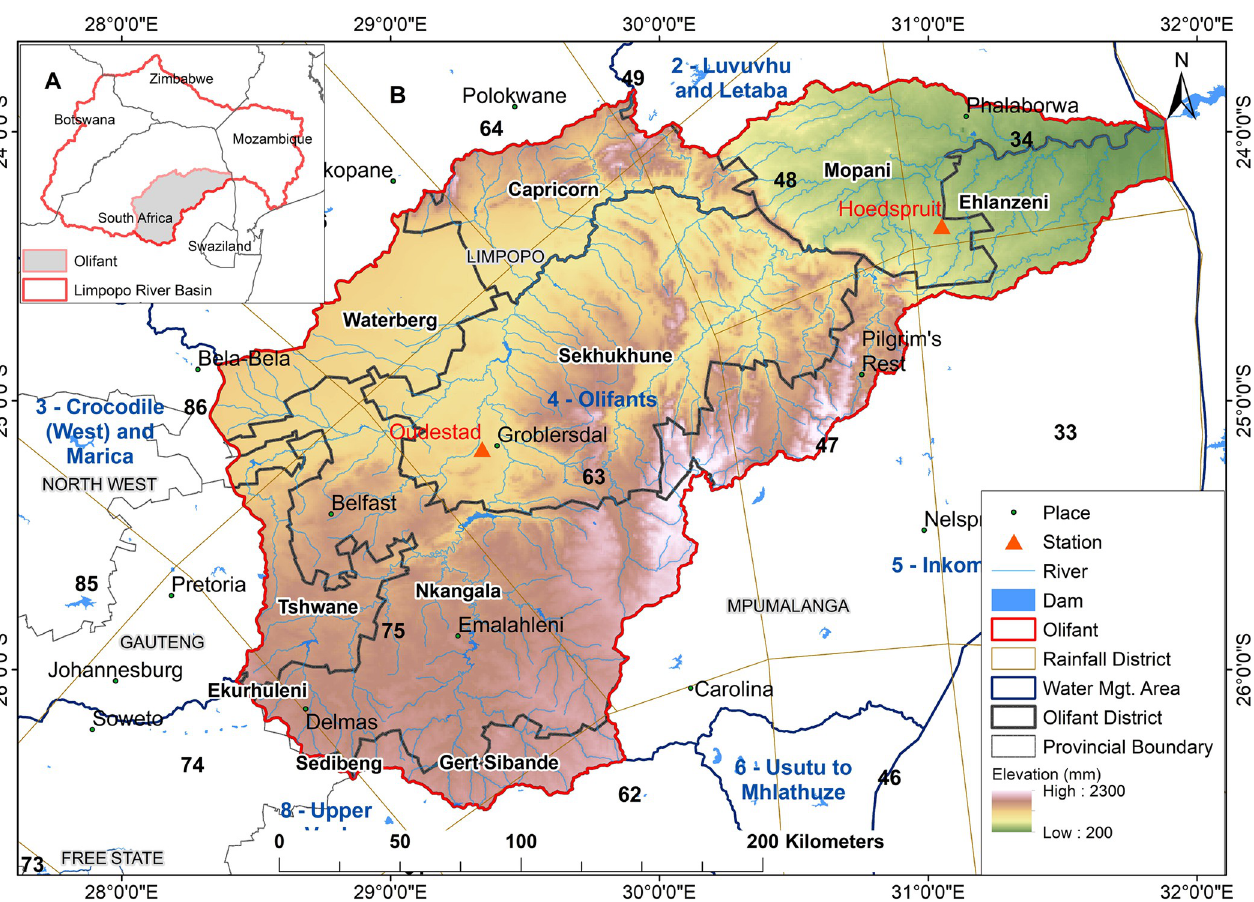
Fig 1. Location of temperature stations and delineation of numbered homogenous rainfall regions used for analysis. The inset map indicates the location of Olifants River Catchment in South Africa. The Place, Station and Rainfall District shapefile in the Figure were acquired database of the South African Weather Service. The River, Dam, Water management shapefile were collected from the South Africa National Department of Water and Sanitation available from [29]. The Geographic administrative shapefile was collected from the Demarcation board of South Africa available from [30]. The elevation data was downloaded from [31].